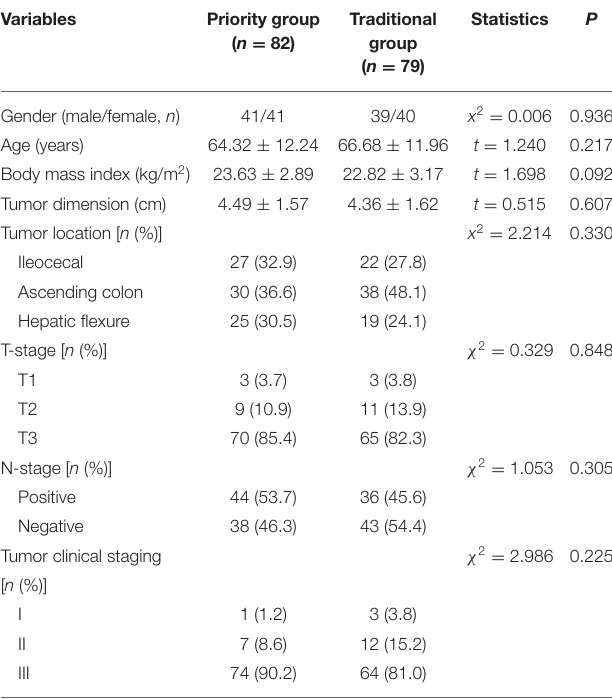
TABLE 1 | Baseline characteristics of patients in the priority group and traditional